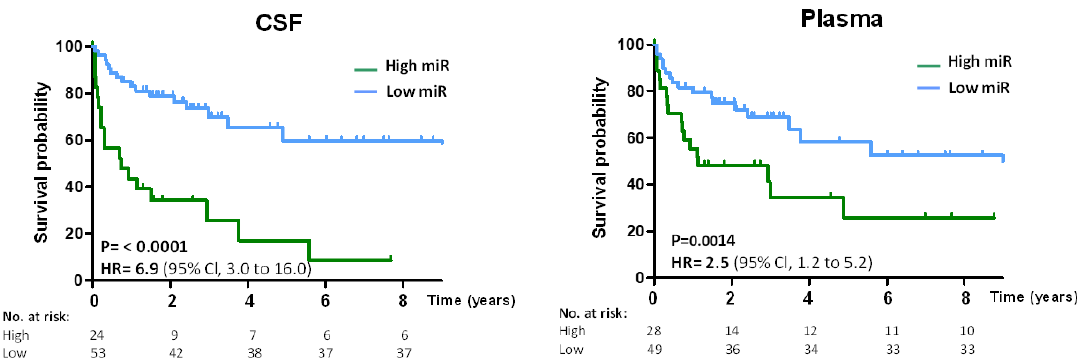
Figure 6. Probability of overall survival in DLBCL according to oncomiR levels in CSF and plasma. Overall survival (OS) Kaplan-Meier estimates of DLBCL patients (with both systemic and concomitant systemic and CNS involvement), stratified by oncomiR index in CSF ( left panel) or plasma ( right panel). For details on OS stratification, see the supplementary